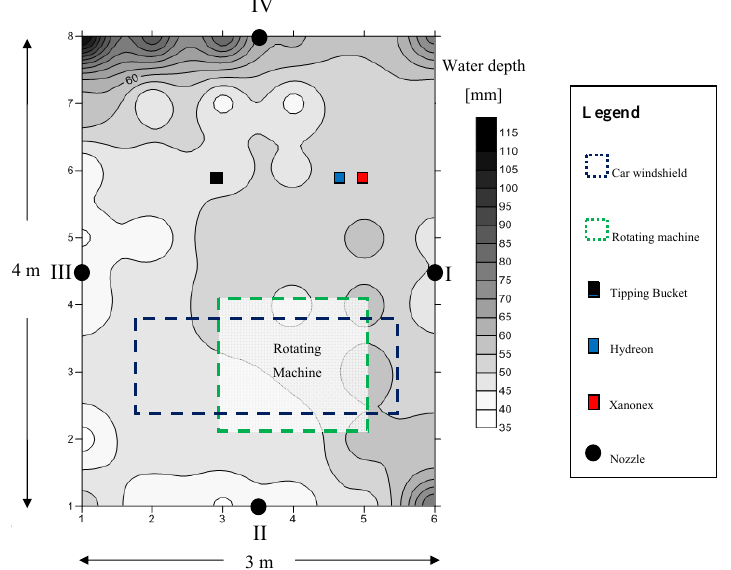
Figure 5. Distribution of the accumulated rainfall depth over the sprinkler area for the case of nozzle combination class 6 with 2 bar pressure and the permanent location of measurement